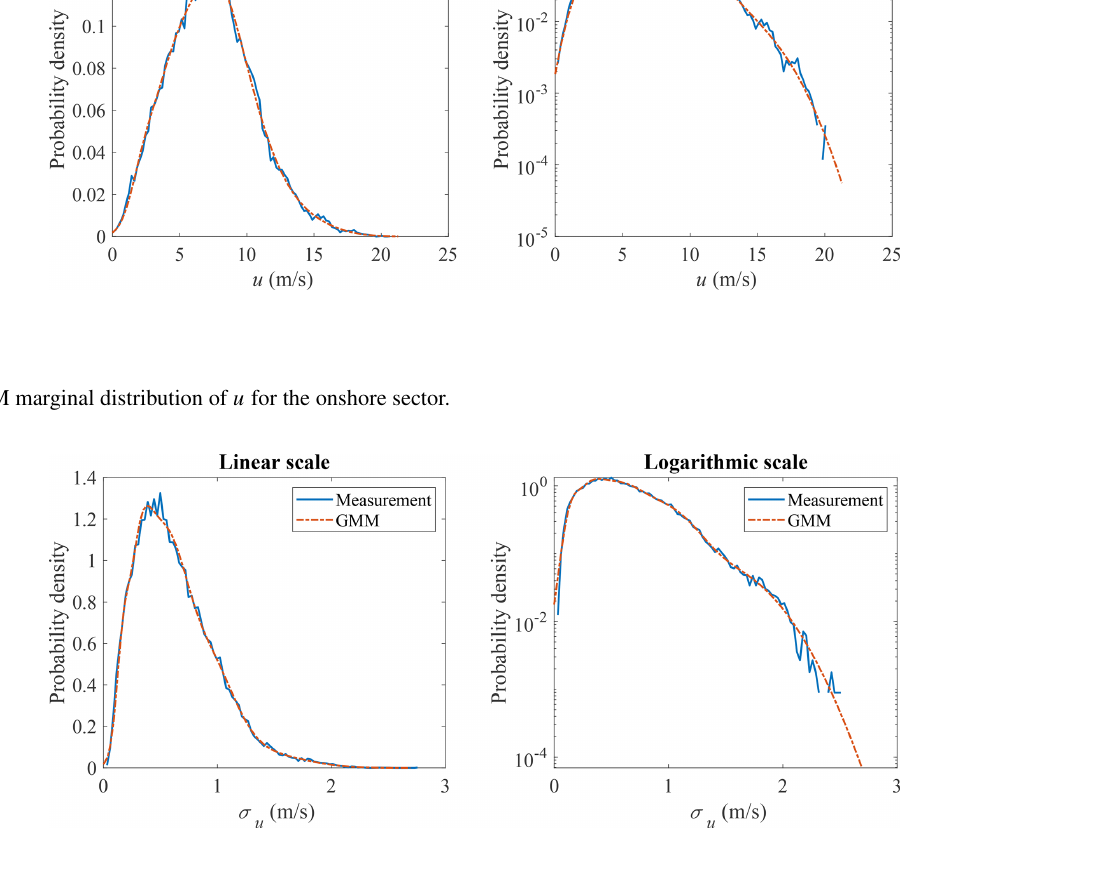
Figure 17. GMM marginal distribution of σ u for the onshore sector.